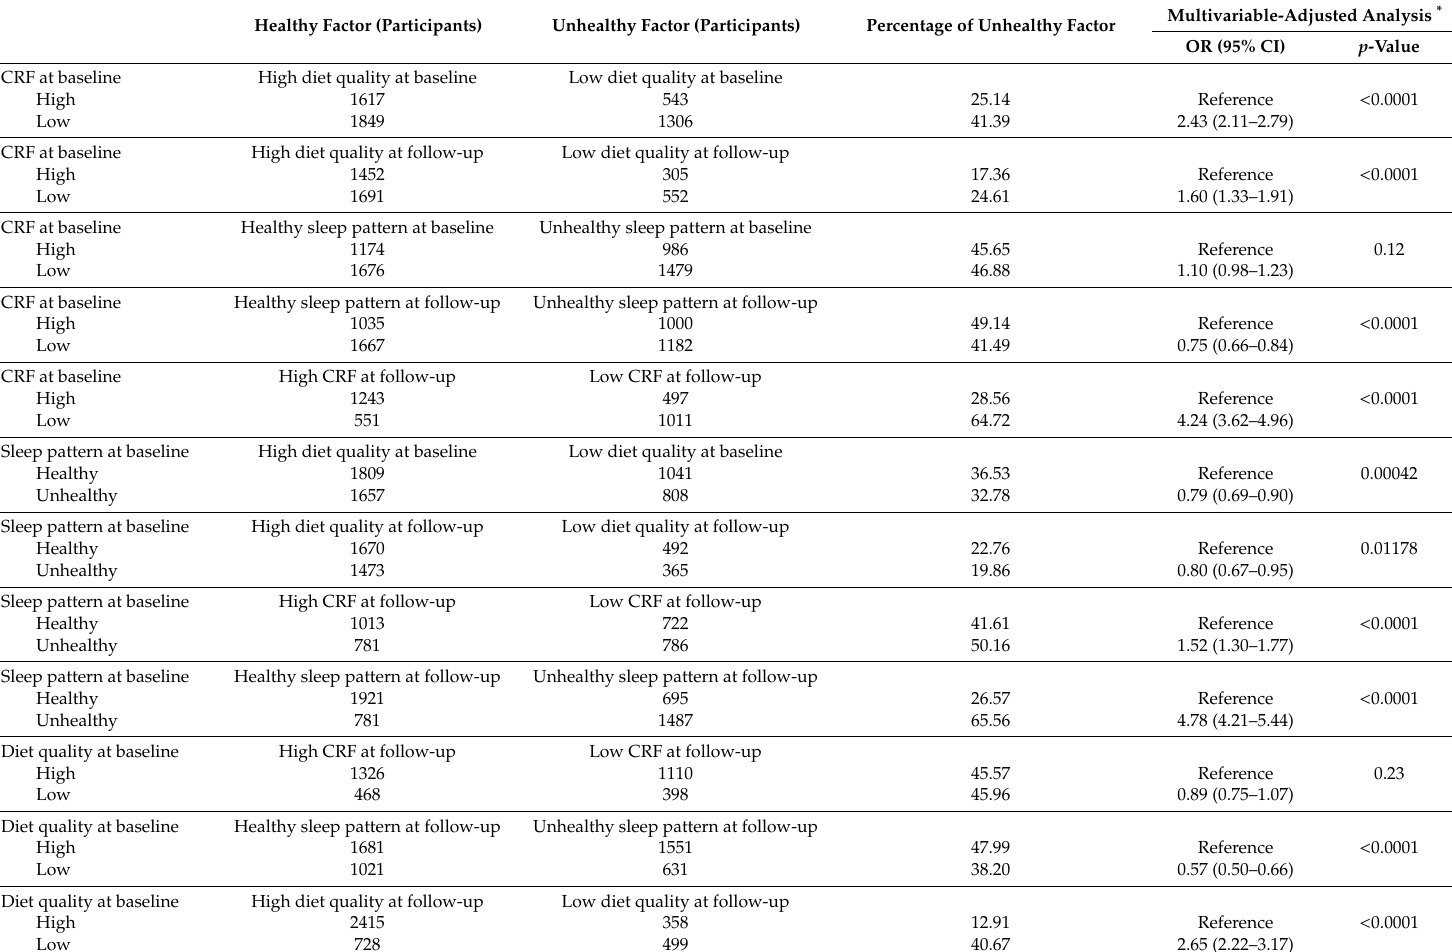
Table 2. Associations between unhealthy